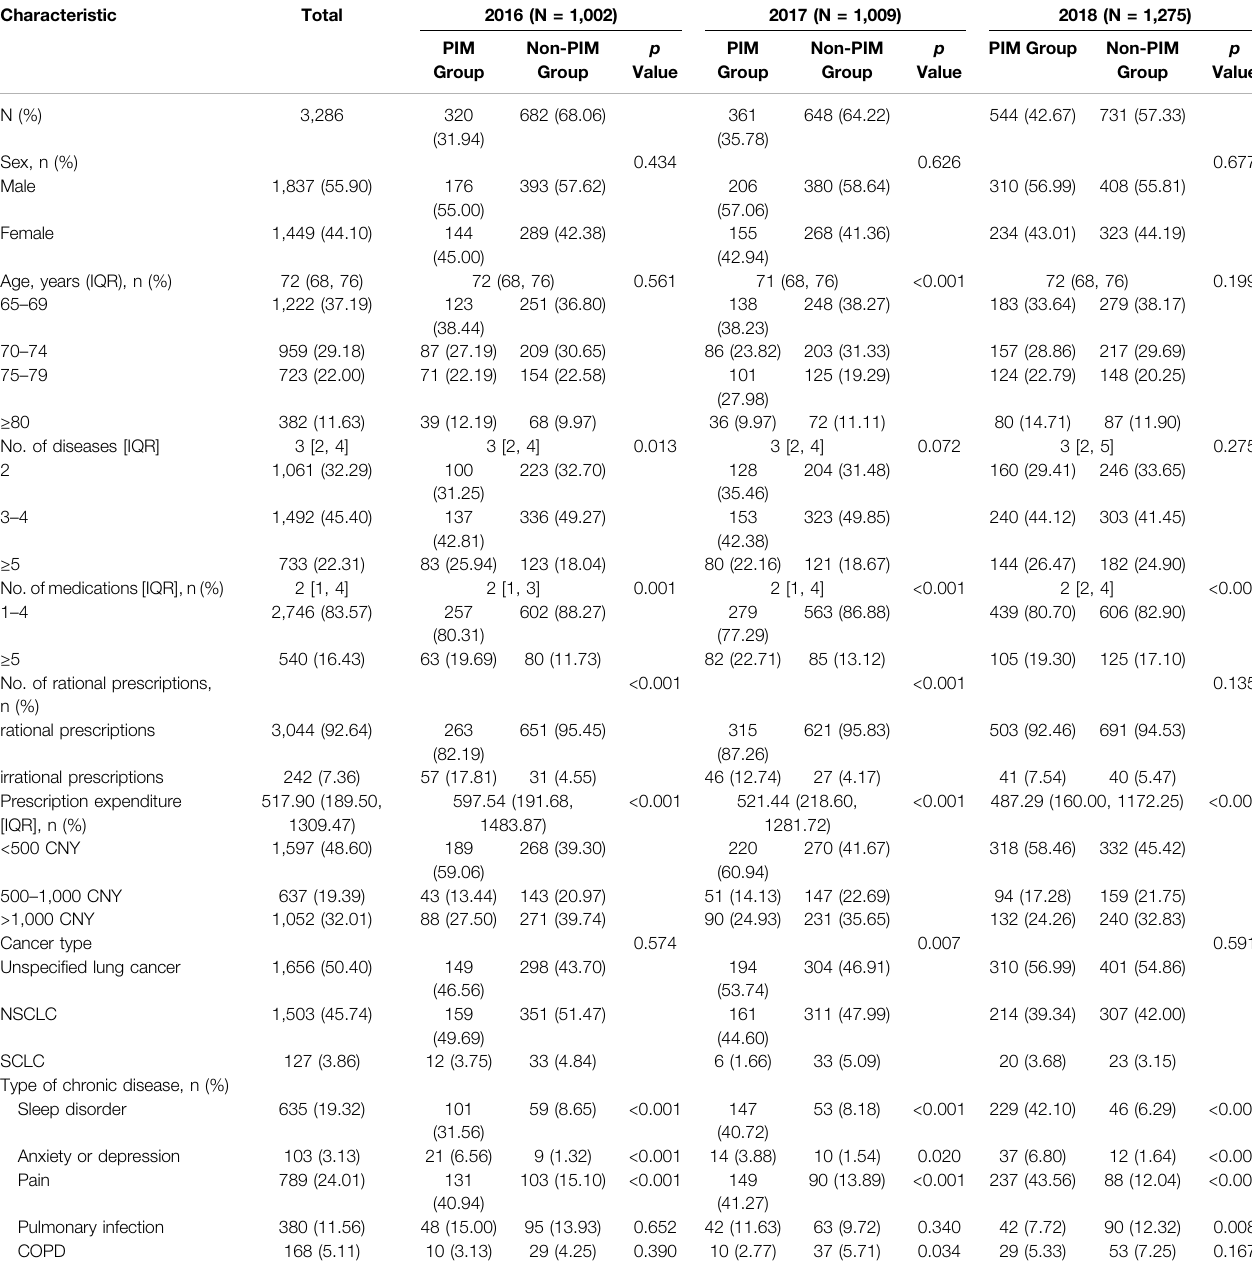
TABLE 1 | Basic characteristics of older lung cancer